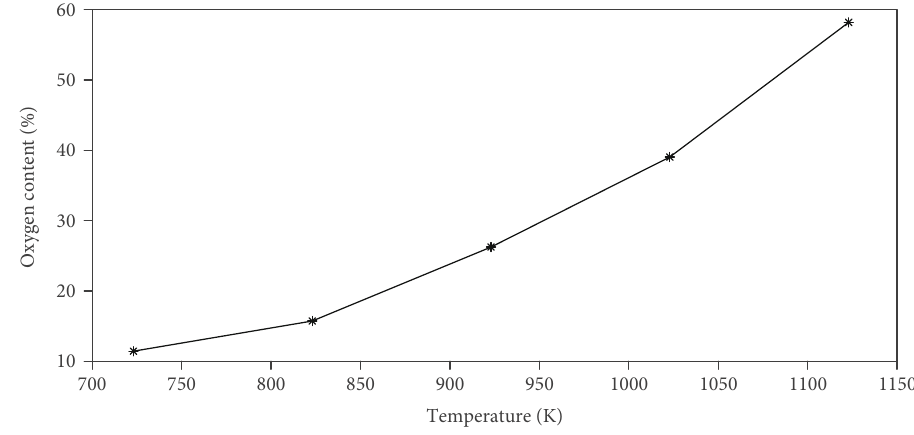
Figure 8: Curve of oxygen content at di ff erent